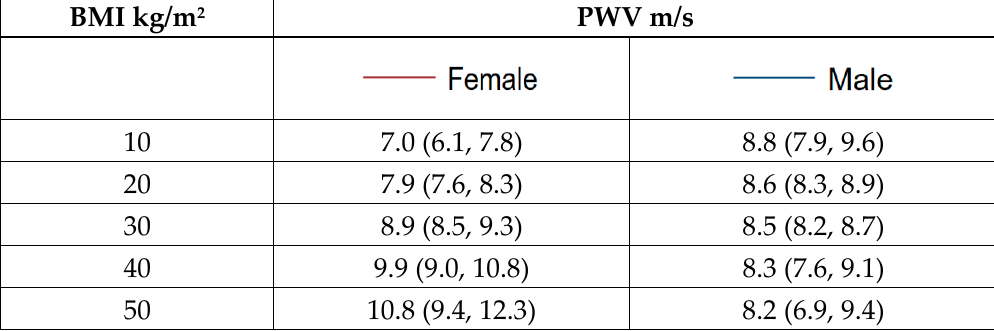
Figure 1. Age adjusted linear regression model with predictive margins to determine the association of BMI with arterial stiffening, measured by carotid-femoral pulse wave velocity (CF-PWV) in the study cohort. Predictive margin analysis indicated a PWV increase of 0.1m/s with every 1 kg/m 2 increase in BMI with female subjects whereas this effect was not seen in male subjects.